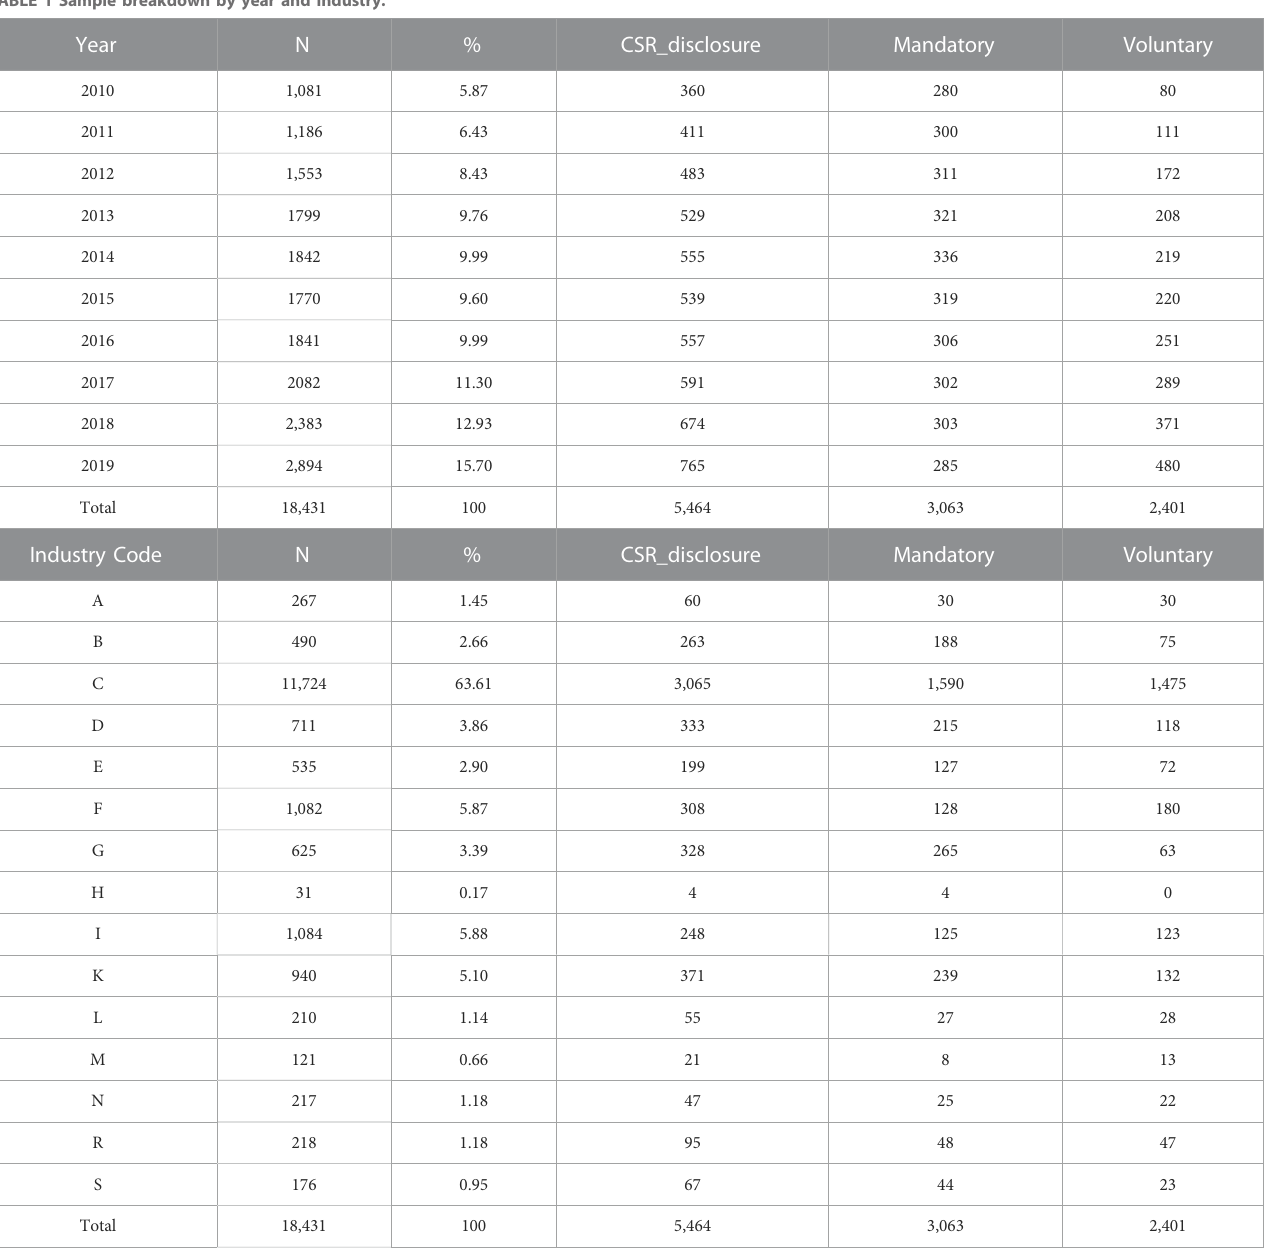
TABLE 1 Sample breakdown by year and